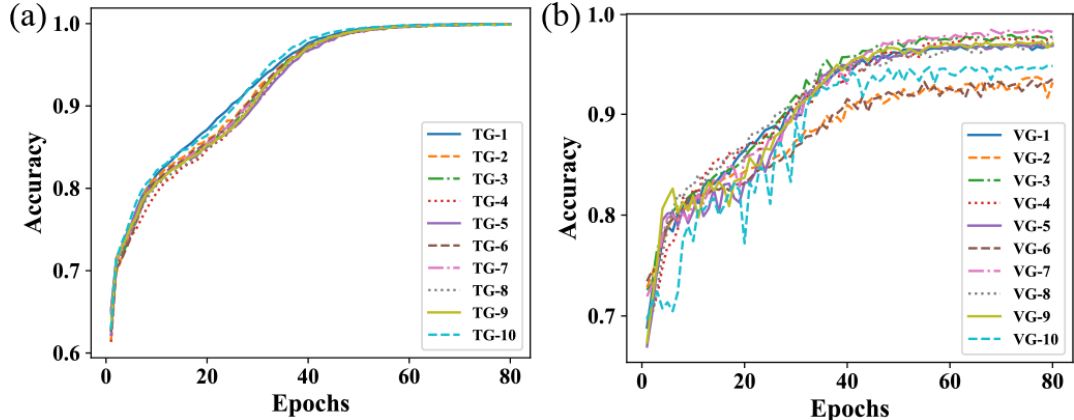
Figure 5. Evolutional curves of the prediction accuracy of the proposed DCNN model for L images, with the (a) training process and (b) validation process.